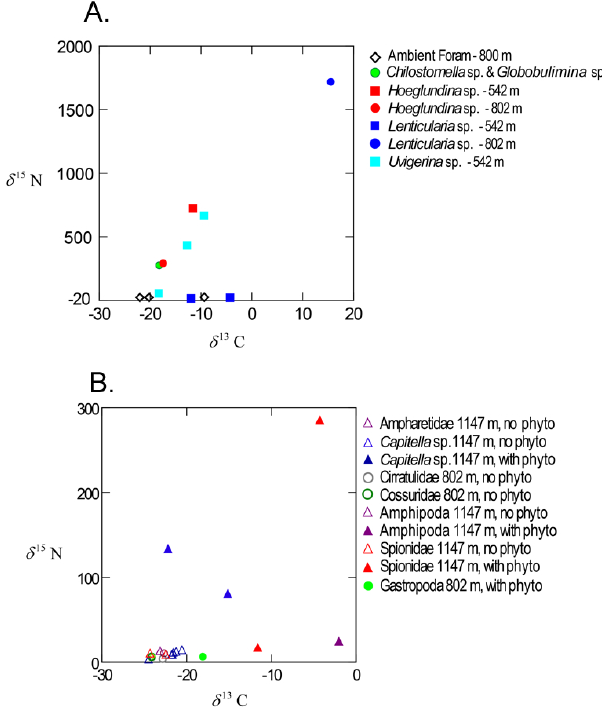
Fig. 9. (A) Dual isotope plot of foraminifera in colonization trays with 13 C/ 15 N labeled phytodetritus added on transect 1 (Squares: 542m trays; Circles: 800m trays) and in ambient sediments (Dia- mond: 800m). (B) Dual isotope plot of metazoan macrofaunal col- onizers in colonization trays with 13 C/ 15 N-labeled phytodetritus added (closed symbols = with phyto) and those without (open sym- bols = no phyto) from 802m on transect 1 and 1147m on transect